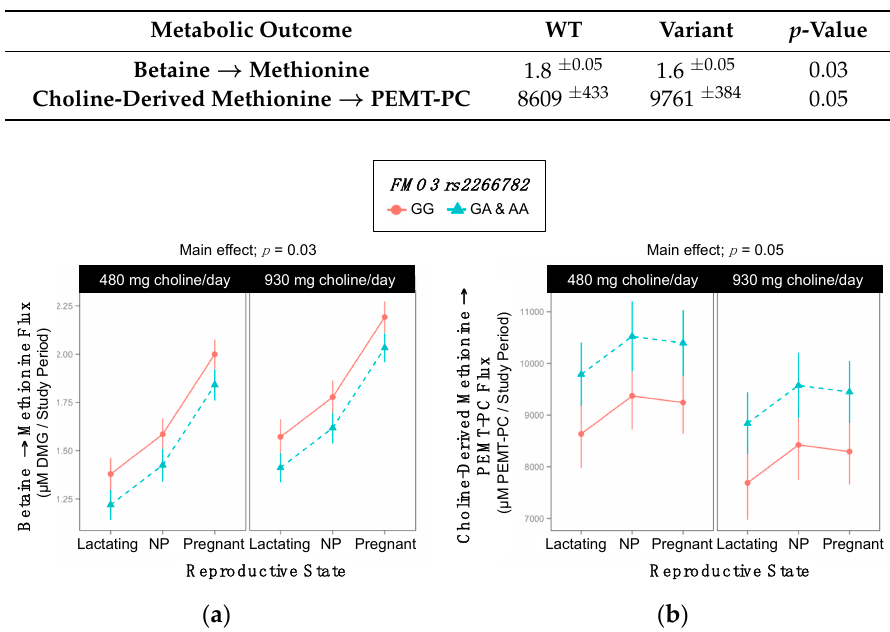
Figure 8. Effect of the FMO3 rs3733890 variant on the metabolic flux and partitioning of dietary choline. ( a ) Betaine → methionine flux; ( b ) Choline-derived methionine → PEMT-PC